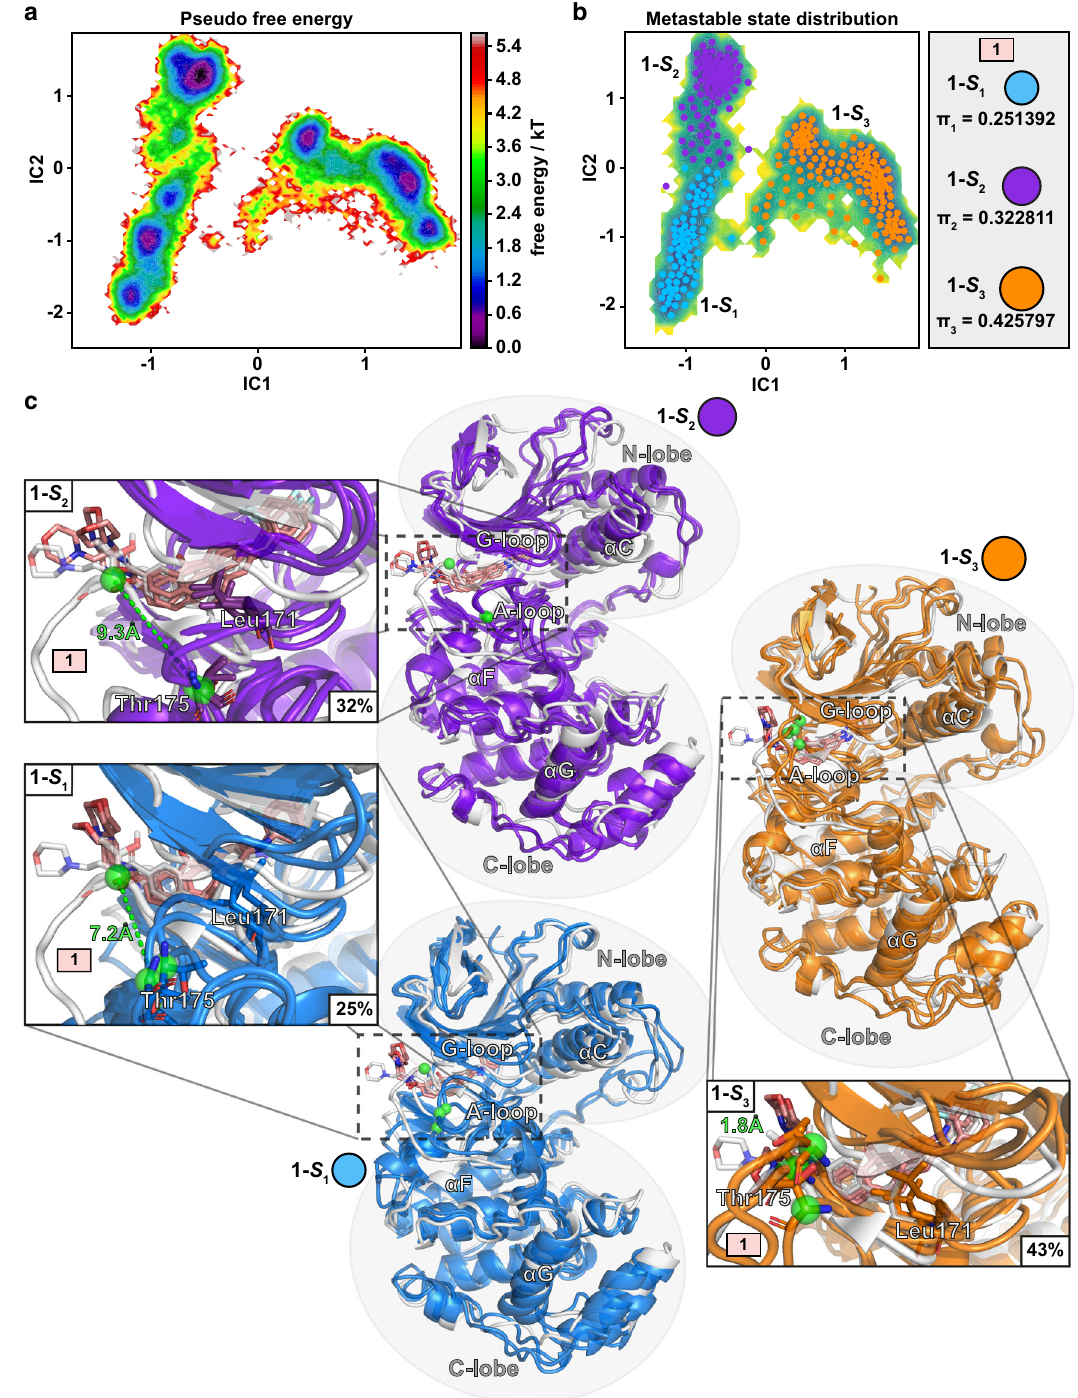
Fig. 2 MSM metastable states of p38 α MAPK-1 complex. a Pseudo free energy map of distributions along time-lagged independent components (ICs) 1 and 2. b Separation of the three metastable states ( 1- S 1 – 1- S 3 ) by PCCA ++ analysis. Equilibrium probability ( π i ) for each state is indicated together with circles, which exhibit an area that is relative to their state probability. c Representative conformations of the metastable states. Each metastable state ( 1-S i ) is illustrated with three representative structures (colored cartoons: 1- S 1 , blue; 1- S 2 , purple; 1- S 3 , orange) and the simulation starting conformation is shown as a reference in gray. Locations of Thr175 C α -atoms are highlighted with green